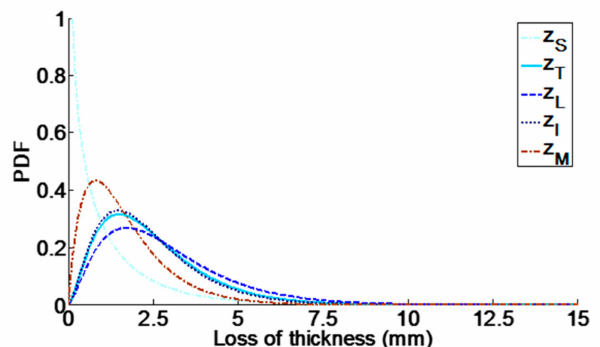
Figure 13. Evolution of the mean and the standard deviation of loss of thickness with time in each zone (exponential fitting). Legend: Z S = Splash zone; Z T = Tidal zone; Z L = Low seawater level zone; Z I = Immersion zone ; Z M = Mud zone.